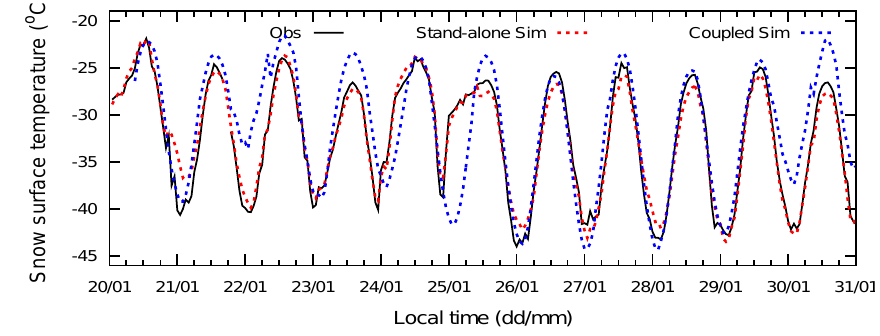
Fig. 8. Comparison between observed snow surface temperature (black solid line) and surface temperature modeled by the coupled snow- atmosphere model (blue dashed line) and by the stand-alone snow model (red dashed line).